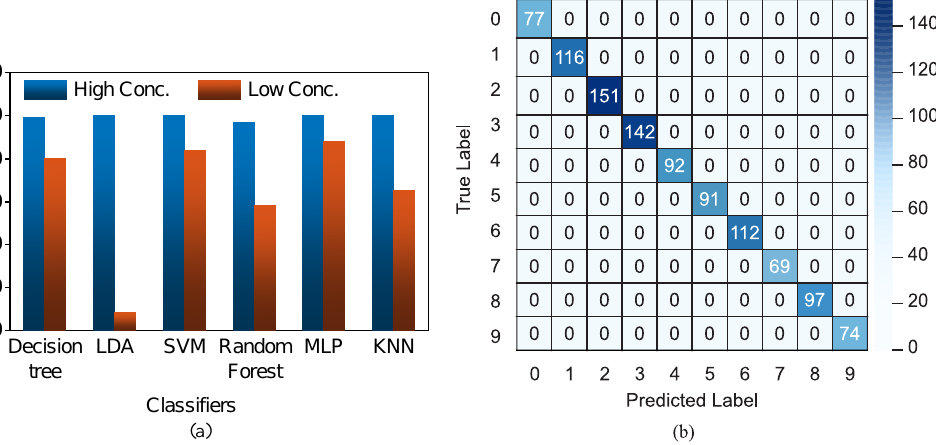
Figure 46. Sensor response classification results with respect to temperature: ( a ) comparison between different classifiers for both high and low concentrations; ( b ) confusion matrix for classification results of methanol in water ( 0 → 4 ) and acetone in water ( 5 → 9 ) . Reprinted with permission from Ref.